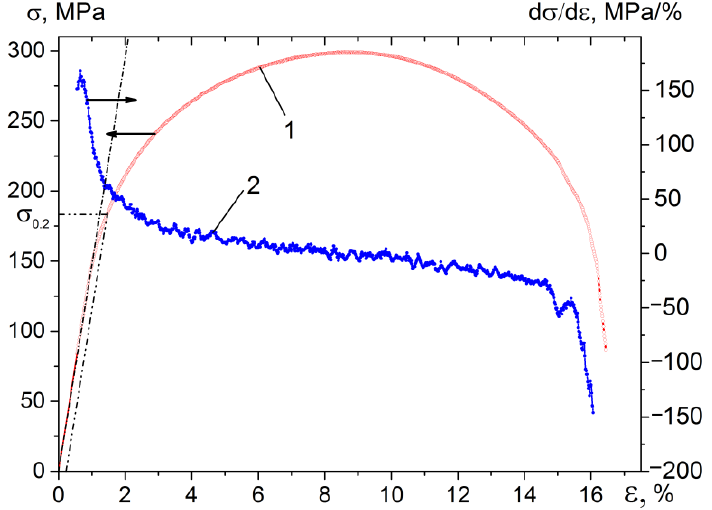
Figure 5. Stress-strain curve of a “copper-steel” specimen (1) and plot of strain-hardening factor versus strain